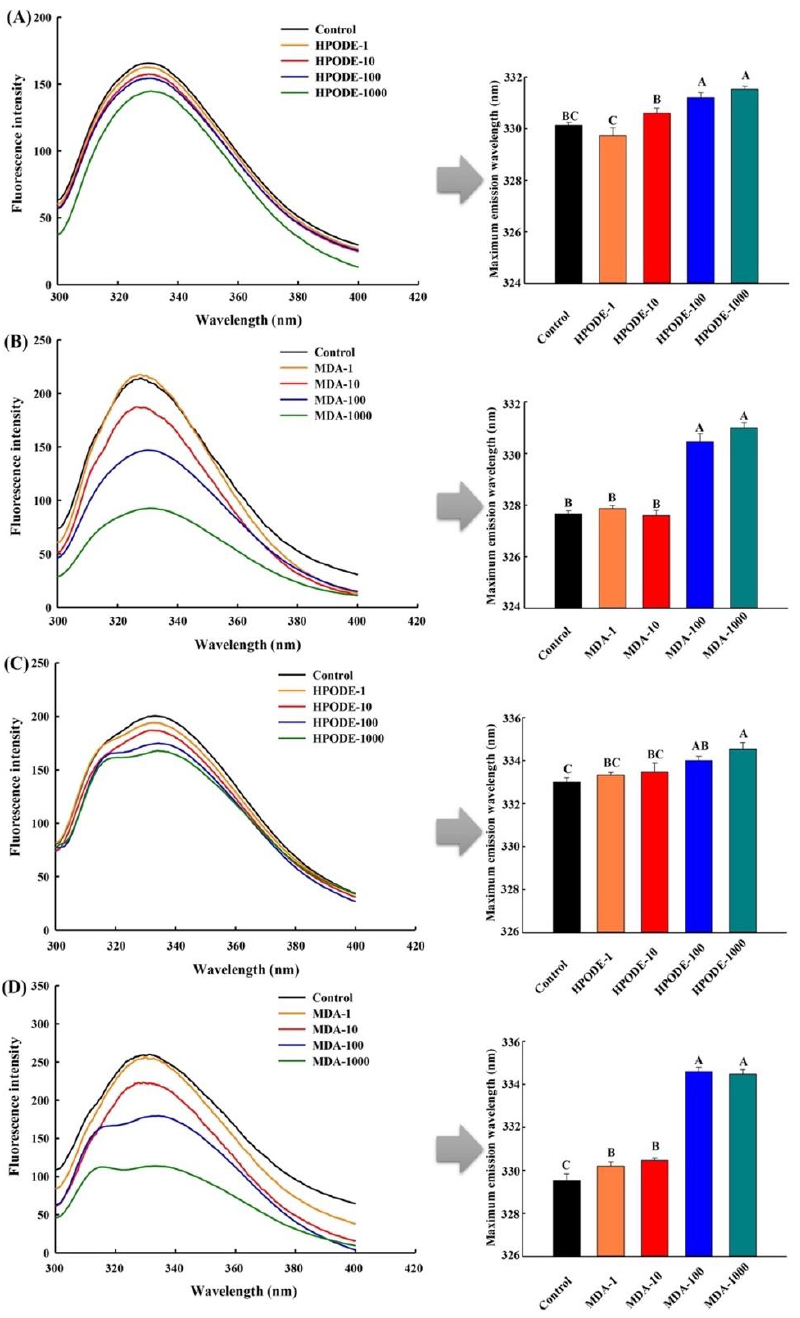
Figure 2. Intrinsic tryptophan fluorescence of the unadsorbed ( A , B ) and adsorbed proteins ( C , D ) extracted from O/W emulsions oxidized by different levels of HPODE and MDA (0, 1, 10, 100, and 1000 µ mol/L emulsion) after 48 h incubation. Corresponding maximum emission wavelengths are shown in the right side.